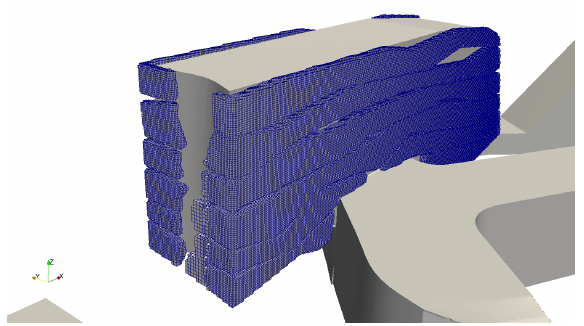
Figure 11. Mesh porosity.